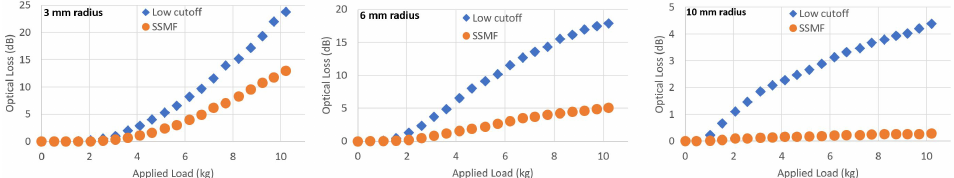
Figure 6. Experimental data comparing bend loss versus load characteristics for standard single mode fibre (SSMF) and low cutoff wavelength fibre. In all cases the fibres were resting on a soft NBR mat, and PVC gapped impactors were used.